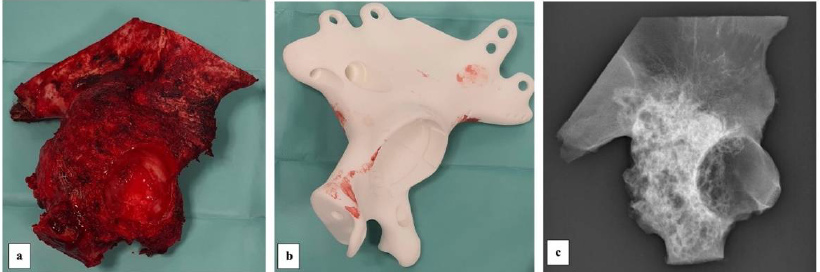
Figure 7. Image of the resection sample ( a ) that fitted in length and width with the preoperatory layout of the implant. This ( b ) may be used to assure the surgeon during the positioning of the cutting guides in case of difficulties. The resection sample was also radiographed (lateral view) ( c ). The bone defect was reconstructed with a custom-made 3D-printed pelvic prosthesis that was fixed with 6.5 mm cancellous screws in the obturator quadratus and in the rem- nant iliac bone (Figure